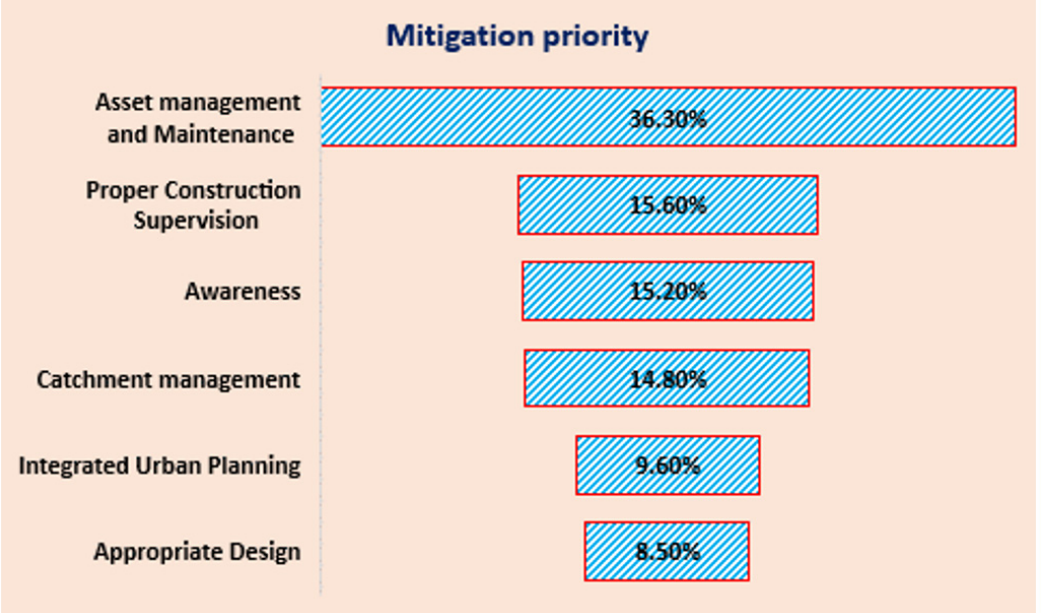
Figure 12. Drainage failure mitigation measure results of AHP with priority